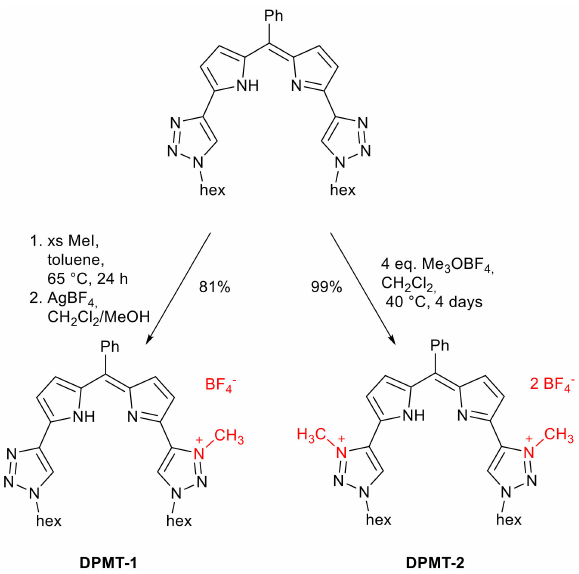
Scheme 2. Synthesis of the mono- and bis-triazolium dipyrromethene ligands using either methyl